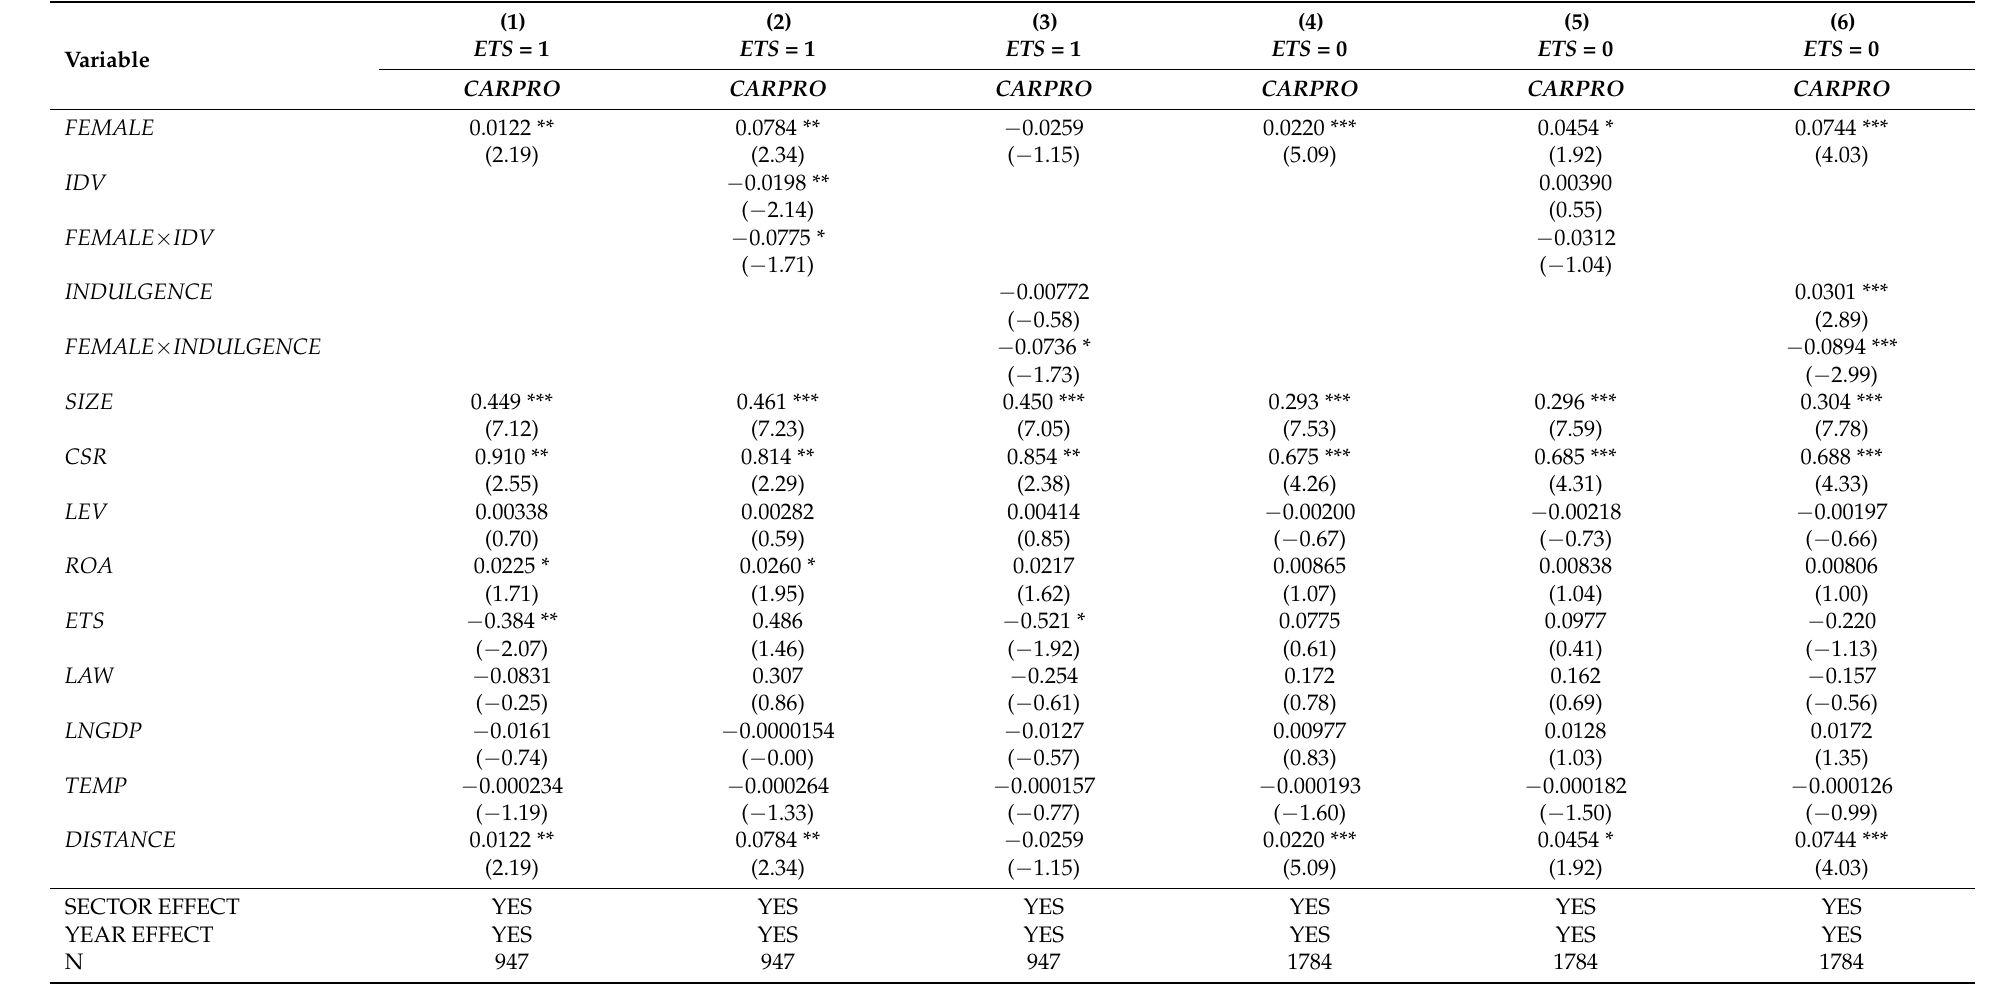
Table 8. Results of subsample analyses based on participation in a national emissions trading